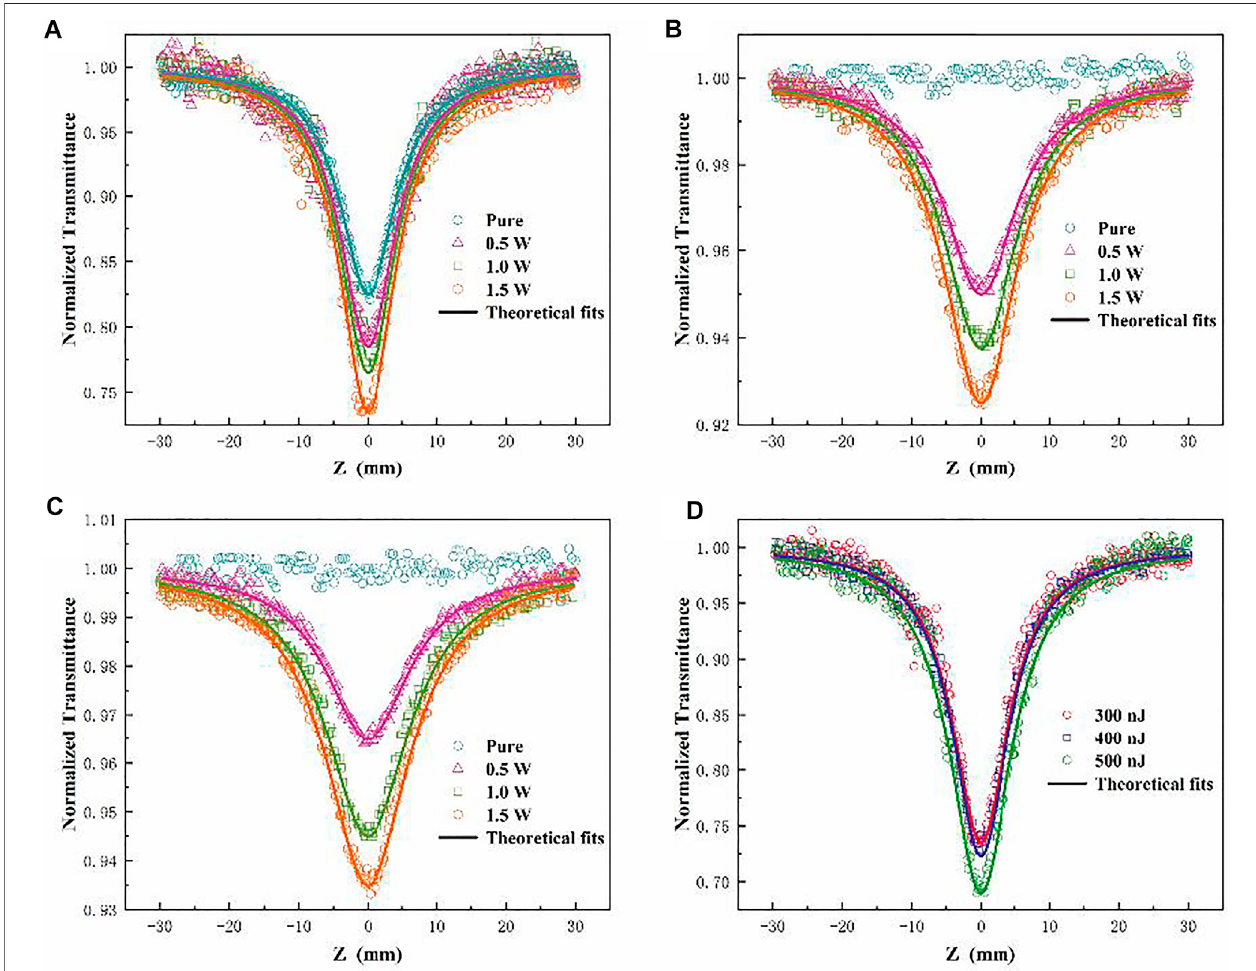
FIGURE 6 | The OA Z-scan signals of pure and Co-doped Sb 2 Se 3 nano fi lms at 800 (A) , 980, (B) , and 1,030 nm (C) . The OA Z-scan signal of Co-doped Sb 2 Se 3 nano fi lm (1.5 W) thin fi lms at 800 nm under different excitation conditions (D) .